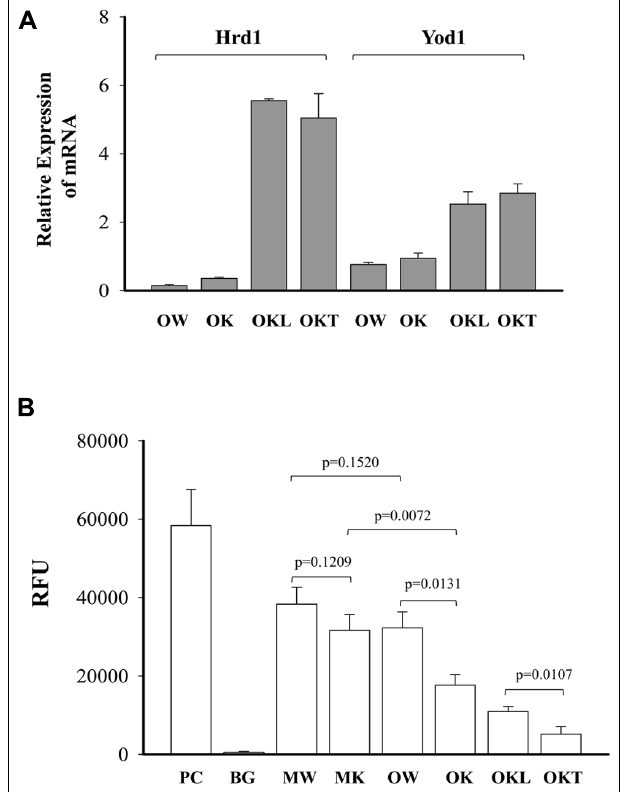
FIGURE 8 | Effects of alcohol and age on mRNA expression of ERAD factors and proteasome activities. (A) Relative expression of mRNA of Hrd1 (synoviolin, an E3 ubiquitin ligase) andYod1 analyzed with quantitative PCR and normalized with Gapdh; (B) comparison of 20S proteasome activities between wild type (WT) and knockout (KO). Data are presented as RFU (relative fluorescent unit) recorded with a fluorometer, n = 5. PC, positive control from analysis kit; BG, negative background; MW, middle-agedWT; MK, middle-aged KO; OW, olderWT; OK, older KO;